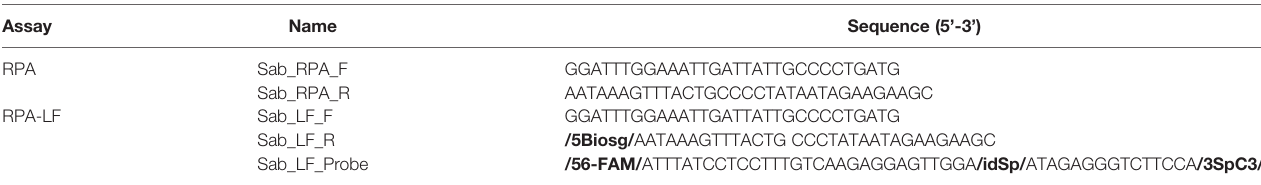
TABLE 2 | Primer and probe sequences targeting Sabella spallanzanii, designed and tested for Recombinase Polymerase Ampli fi cation (RPA) and Recombinase Polymerase Ampli fi cation with lateral fl ow read-out (RPA-LF) analyses used in this study.